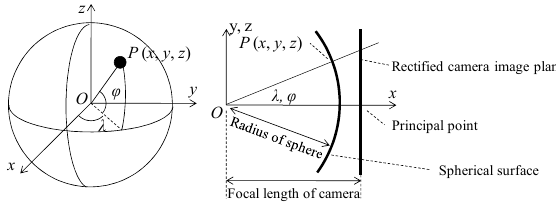
Figure 5. Camera image projection onto a spherical